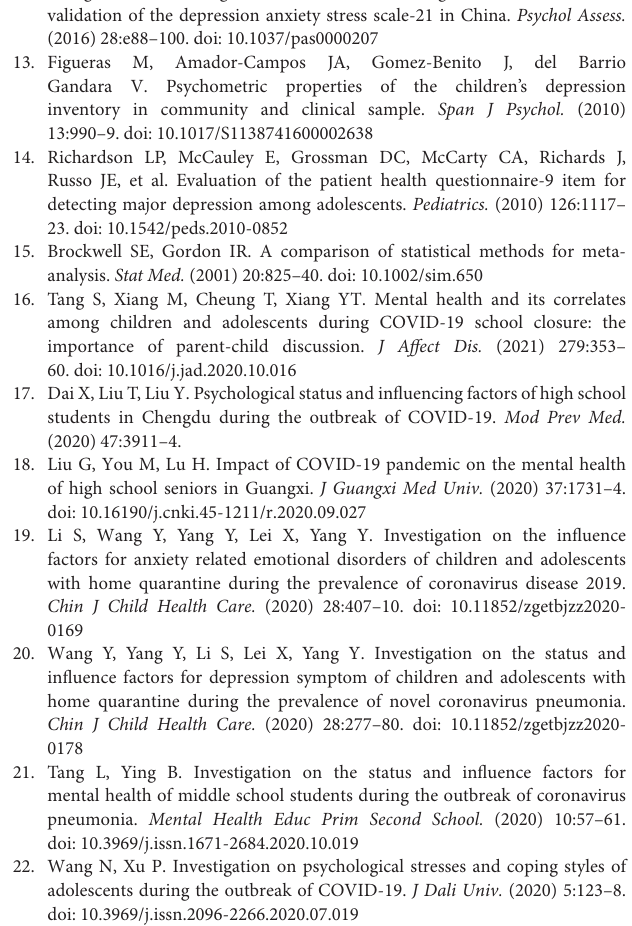
Supplementary Figure 1 | The funnel plot of the meta-analysis. Supplementary Figure 2 | The sensitivity analysis for the included